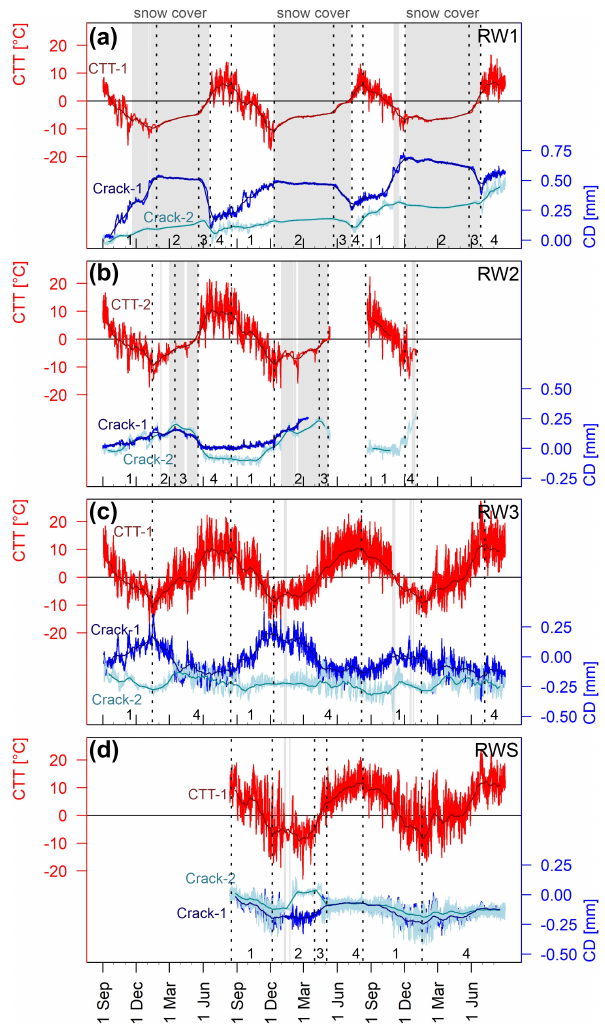
Figure 6. Crack-top temperature, monthly mean crack-top temper- ature, crack deformation and monthly mean crack deformation for the crackmeters at (a) RW1, (b) RW2, (c) RW3 and (d) RWS for the period 1 September 2016 to 31 August 2019. Grey rectangles high- light the snow cover period, while numbers indicate the interpreted phases (see Table 4).